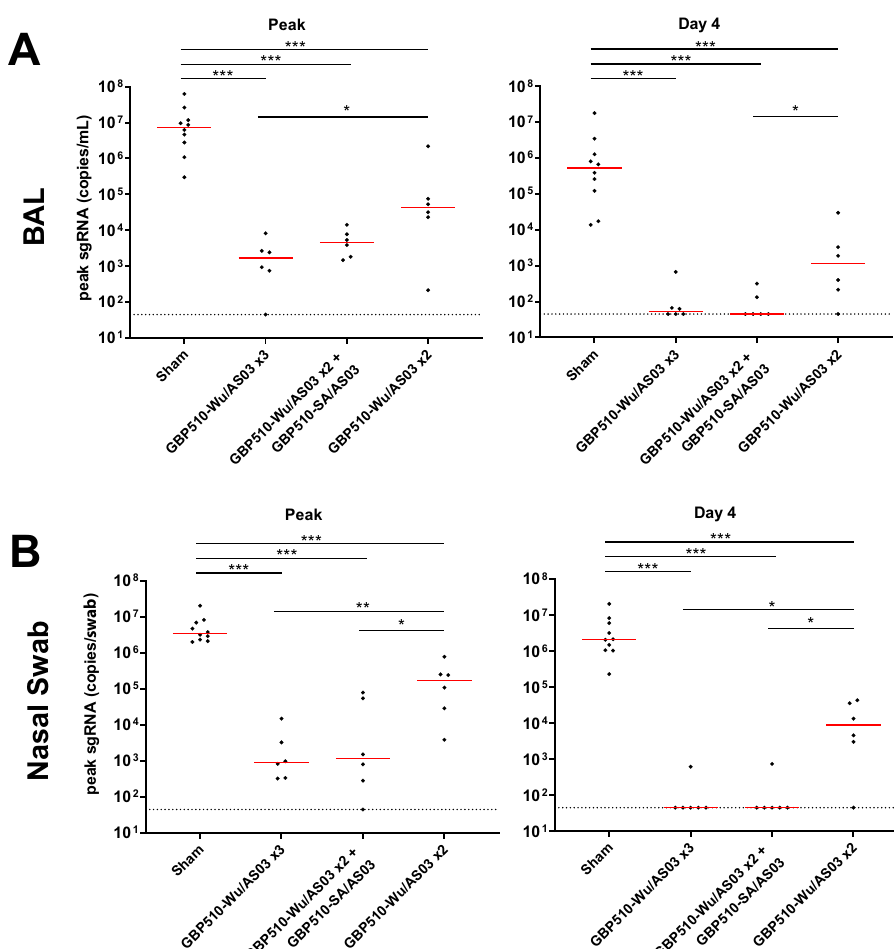
Fig. 5 Peak and day 4 viral loads following challenge with delta SARS-CoV-2. Group 1 received three sham doses, Group 2 received three doses of GBP510-Wu, Group 3 received two doses of GBP510-Wu and one dose of GBP510-SA, and Group 4 received two doses of GBH510-Wu and one sham dose. A Subgenomic RNA (sgRNA) copies/mL in the bronchoalveolar lavage (BAL) following Delta SARS-CoV-2 challenge at peak and at Day 4 postchallenge. Median lines are shown with red bars. Vaccinated groups were compared with sham controls by two-sided Mann-Whitney tests. *** p < 0.0005, * *p < 0.005, * p < 0.05. B Subgenomic RNA (sgRNA) copies/swab in the nasal swabs (NS) following Delta SARS-CoV-2 challenge at peak and at Day 4 postchallenge. Median lines are shown with red bars. Vaccinated groups were compared fi t to the standard curve. The upper limit of detection was de fi ned as 2×10 6 RLU for each assay and the signal for samples, which exceeded this value at 1:5,000 serum dilution was run again at 1:50,000 and the fi tted RLU was multiplied by 10 before reporting. The lower limit of detection was de fi ned as 1 RLU and an RLU value of 100 was de fi ned to be positive for each assay.